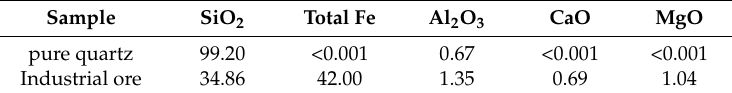
Table 1. Chemical composition of experimental ore samples (wt %).